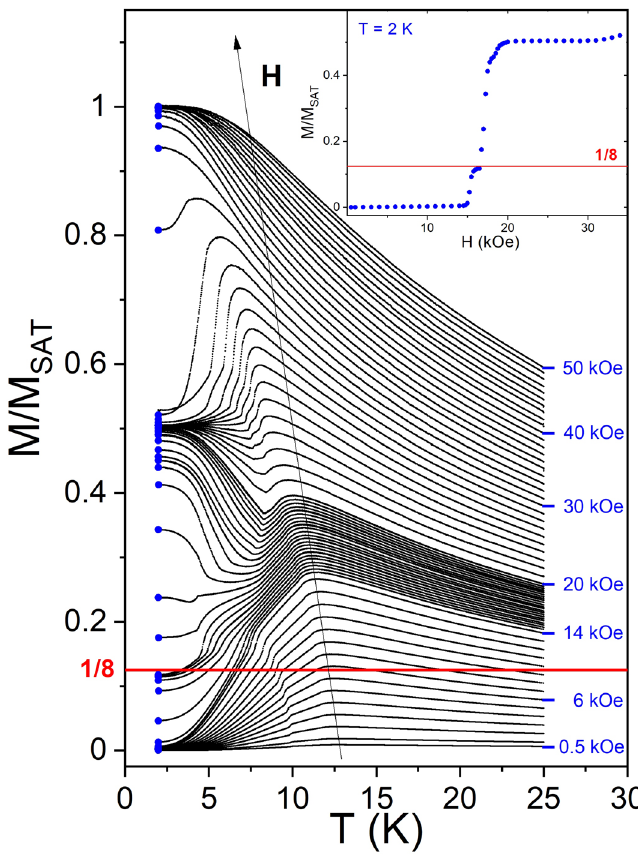
Figure 1. Temperature dependence of magnetization M on cooling from 25 K (paramagnetic state) to 2 K (ordered state) in various constant magnetic fields. The inset shows the derived field dependence of M at 2 K which exhibits a distinct thermodynamically stable 1/8 fractional plateau (sFP).